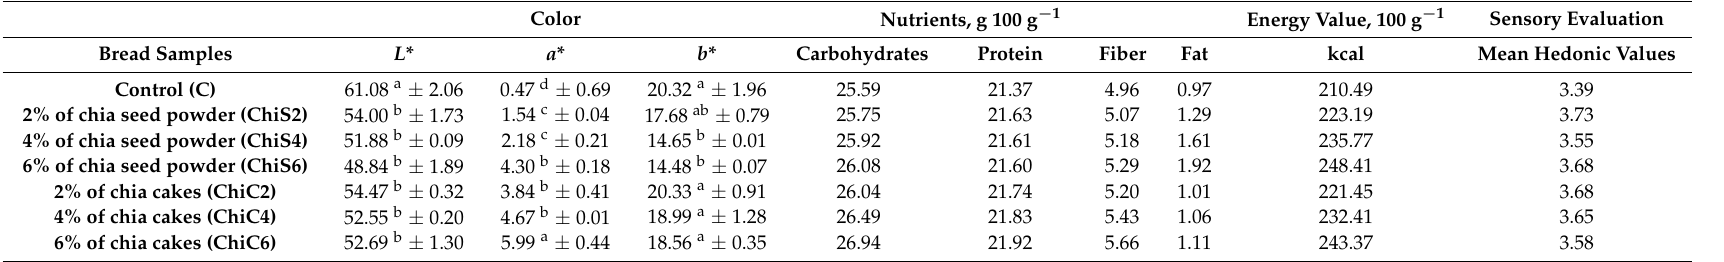
Table 1. Crumb color analysis, nutritional, energy values, and mean Hedonic values of different bread samples.